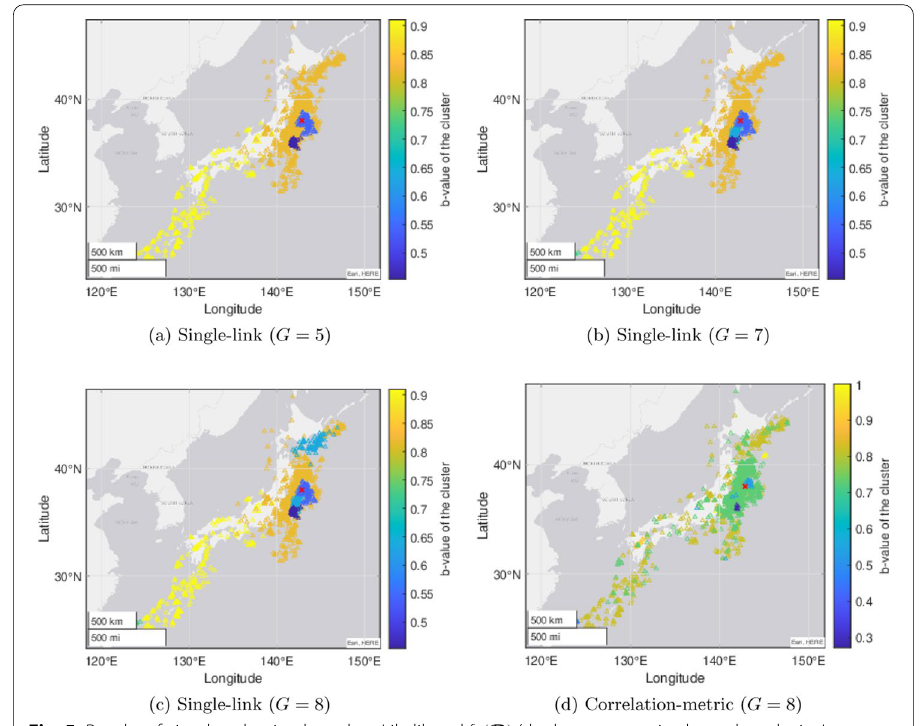
Fig. 5 Results of visual evaluation based on Likelihood f 2 ( R ) (the largest magnitude earthquake in Japan m max = 9.0 is indicated by red